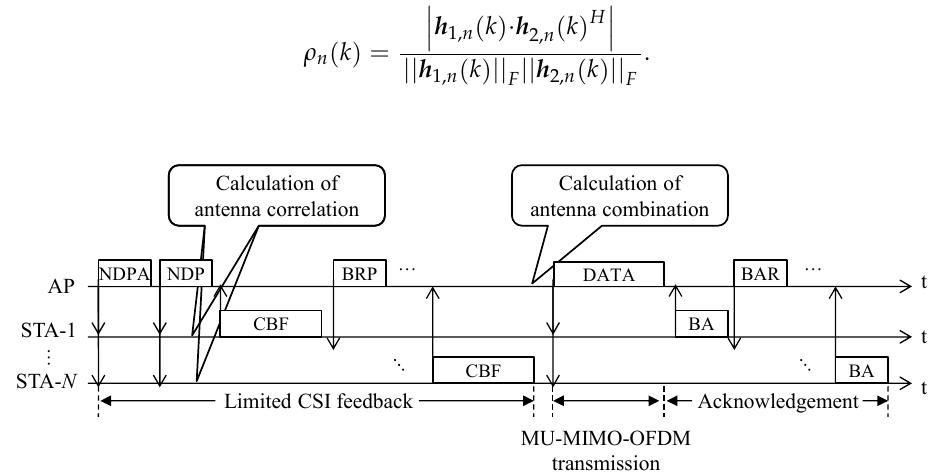
Figure 2. Proposed frame sequence, including limited channel state information (CSI) feedback, MU-MIMO-OFDM transmission, and acknowledgement subsequences based on frame formats of IEEE802.11ac [6].